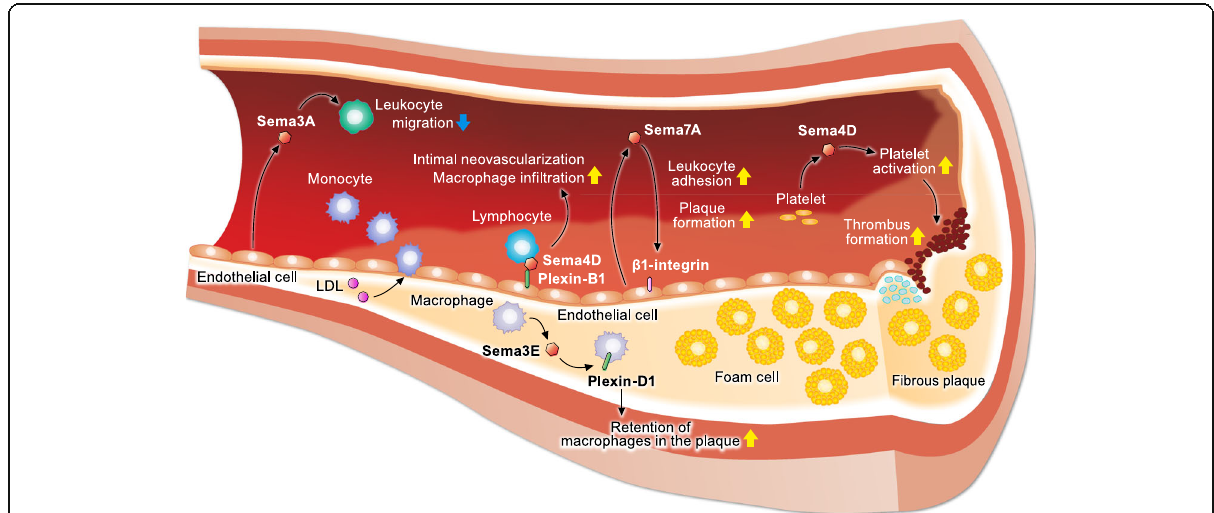
Fig. 3 Role of semaphorin signaling in the pathogenesis of atherosclerosis. Sema4D promotes the development of atherosclerosis by promoting thrombus formation, intimal neovascularization, and recruitment of macrophages into atherosclerotic plaques. In addition, Sema7A aggravates plaque formation in atherosclerosis by promoting leukocyte adhesion and vascular inflammation. In contrast, Sema3A inhibits leukocyte rolling, adhesion, and transmigration into atherosclerotic lesions, resulting in the suppression of inflammatory responses in